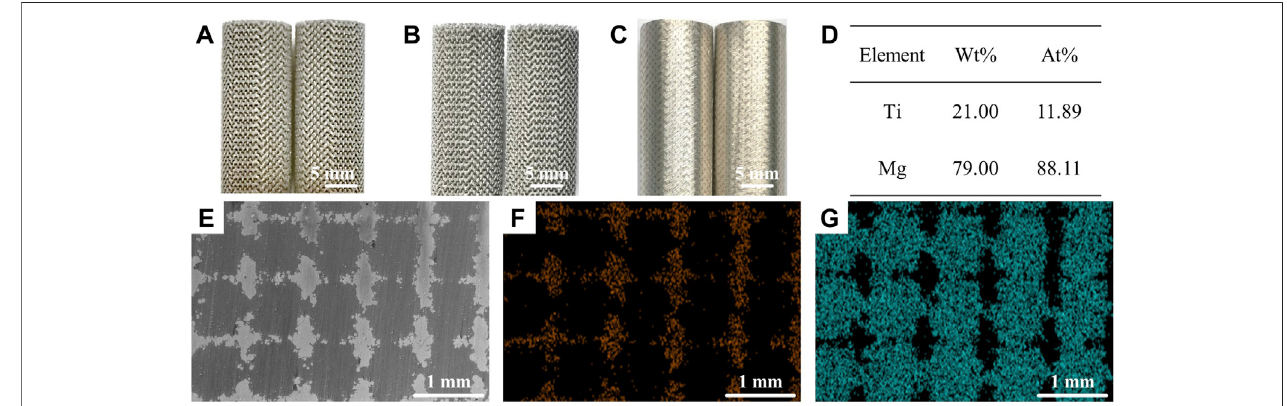
FIGURE 2 | (A) Corroded surface photographs of pure Mg and Mg-Ti composite (corrosion products were removed). (B) pH values of pure Mg and the Mg-Ti composite in the α -MEM solution with 10% FBS at 37 ° C and 5% CO 2 . (C) Weight loss of pure Mg and Mg-Ti composite.